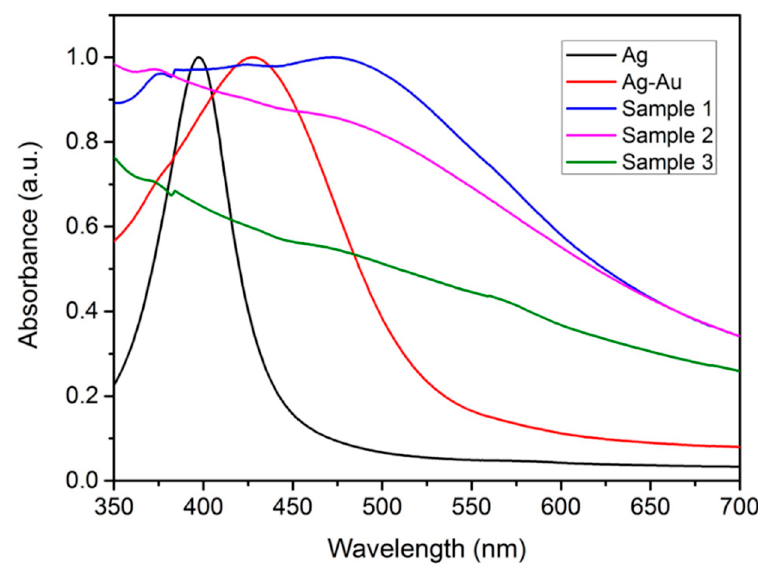
Figure 5. Normalized UV-vis spectra of Ag nanospheres (black line), hollow Ag-Au nanostructures (red line), and Pt nanocluster-anchored hollow Ag-Au nanostructures with injected molar ratios of Pt / Au at 1 (blue line), 2 (purple line) and 3 (green line).